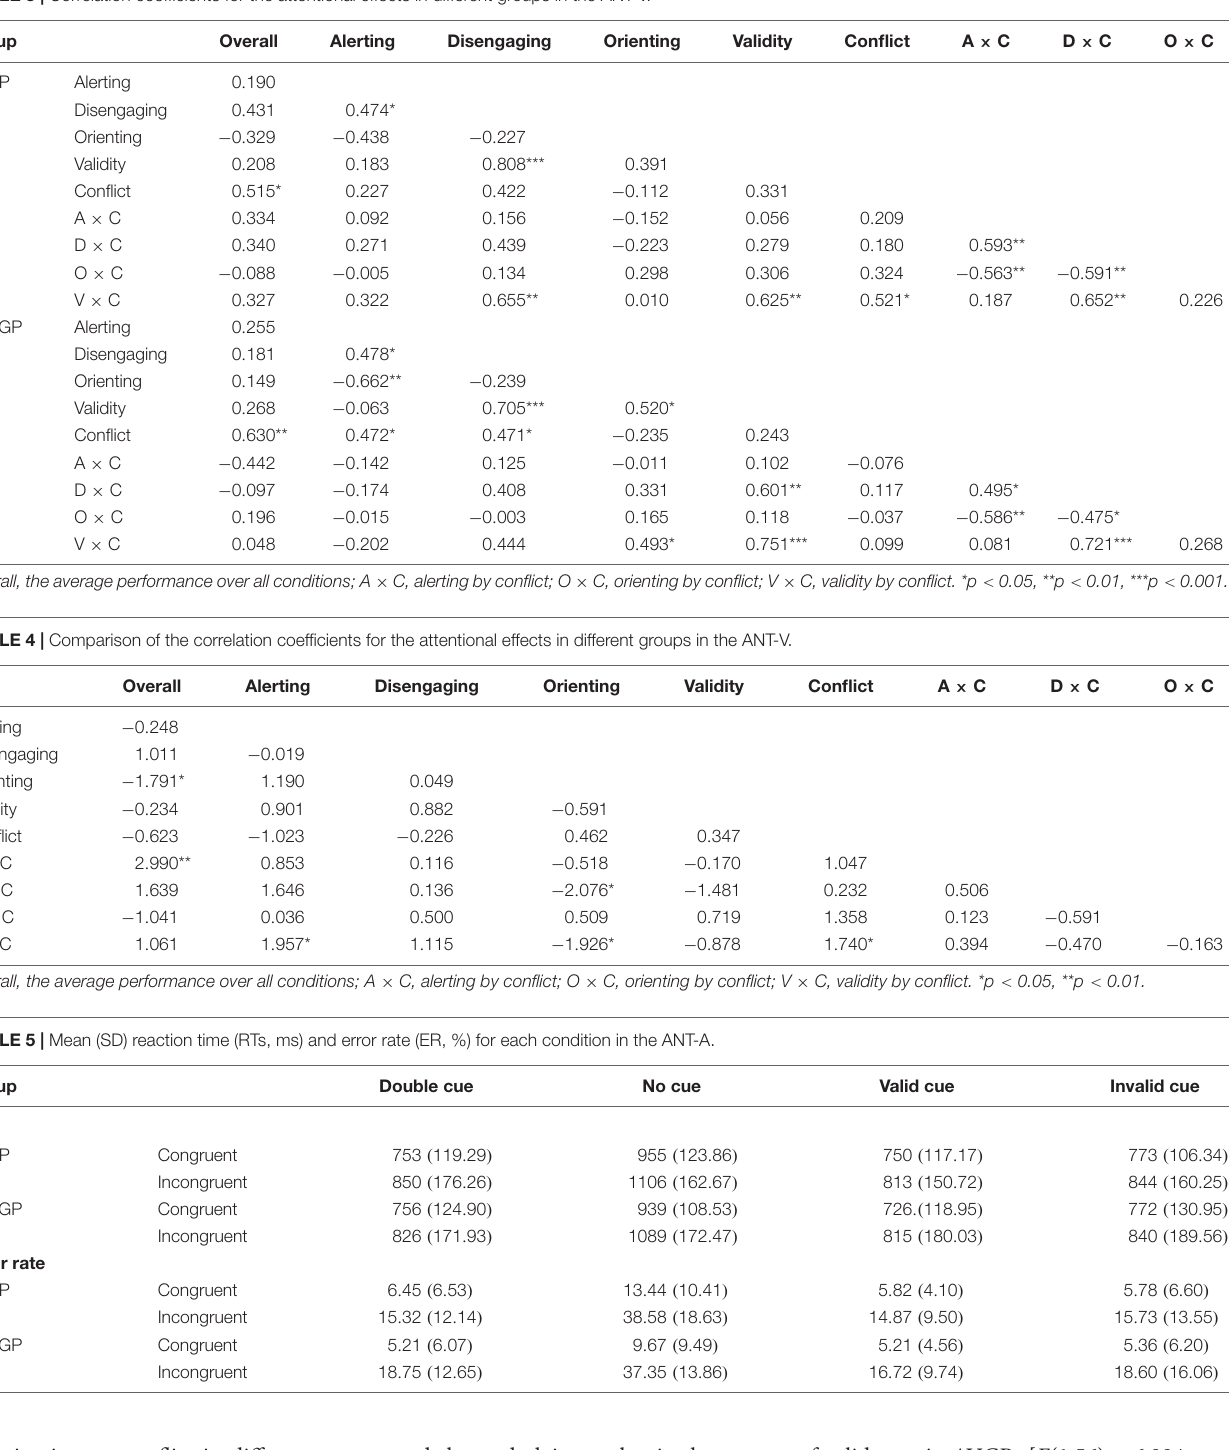
TABLE 3 | Correlation coefficients for the attentional effects in different groups in the ANT-V.